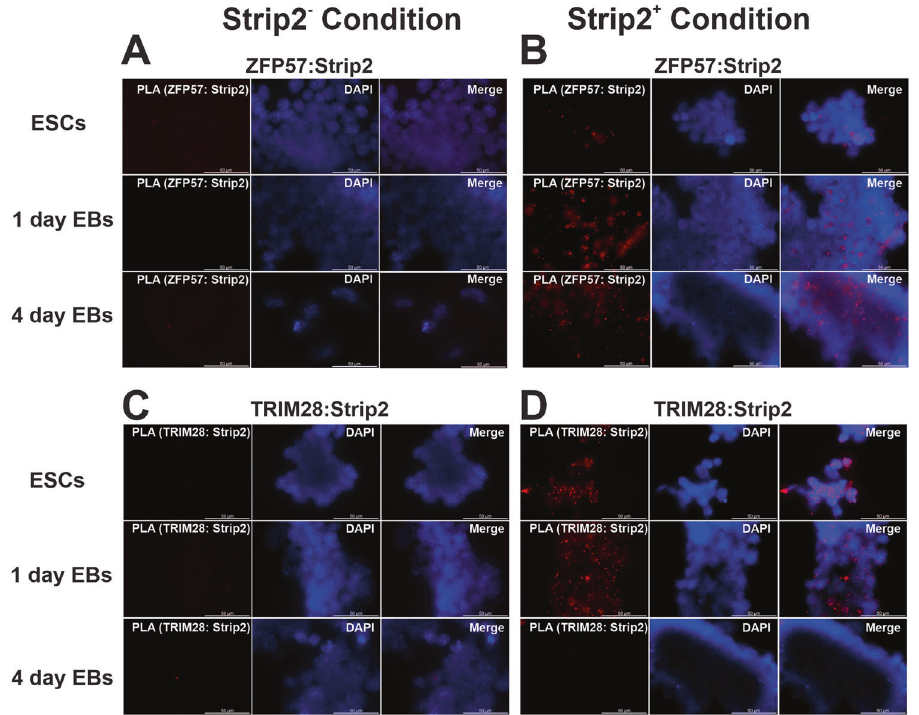
Fig. 7 Representative images from proximity ligation assay (PLA): Assays were performed on Strip2 − -ESCs vs Strip2 + -ESCs at different time point of differentiation (0-day, 1-day and 4-day EBs). A Absence of proximity (distance < 40 nm) red dots between Strip2 and ZFP57 in Strip2 − -ESCs condition in all three time points. B Evidence of proximity (distance < 40 nm) red dots found between Strip2 and ZFP57 in all three time points. C Absence of proximity (distance < 40 nm) red dots between Strip2 and TRIM28 in Strip2 − -ESCs condition in all three time points. D Strip2 and TRIM28 proximity (distance < 40 nm) red dots were found only in 0-day ESCs and 1-day EBs but not in 4-day EBs. Nuclei are counterstained with DAPI (blue fl uorescent stain). Scale bar: 50 μ